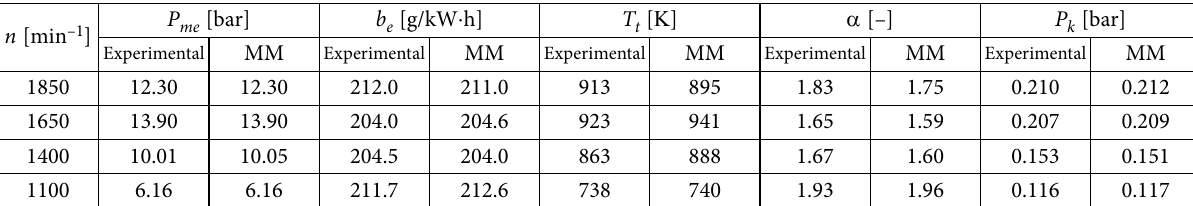
Table A2. Comparison of diesel engine MTU 8V 396TB MM adequacy validation experiment and modelling results